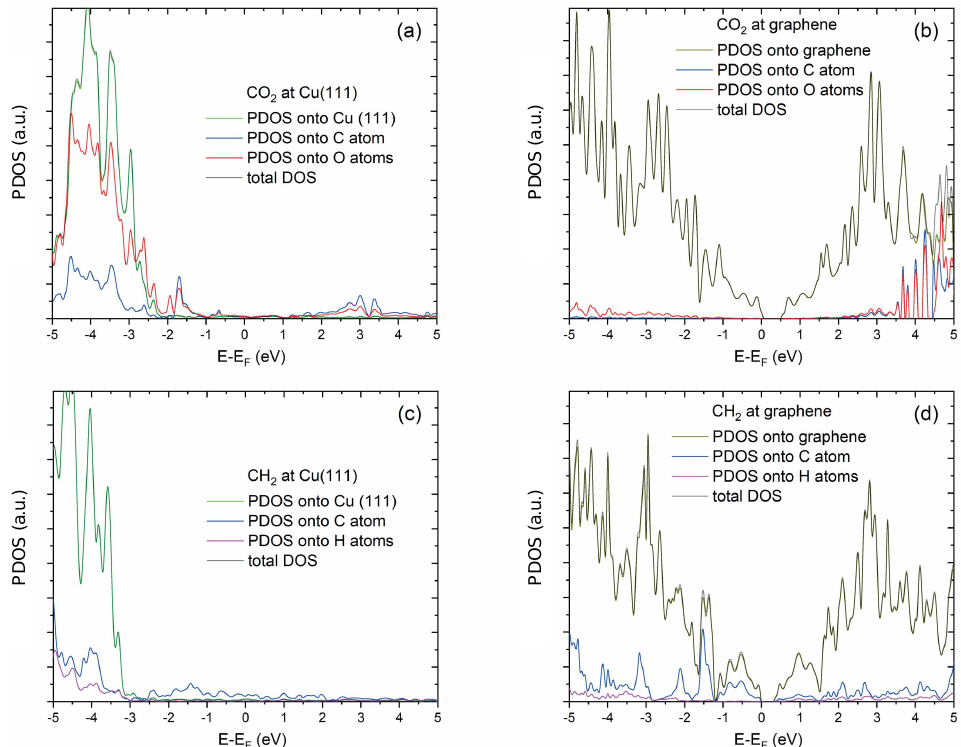
Figure 5. Projected density of states (PDOS) calculated for ( a ) CO 2 adsorbed at Cu (111) surface, ( b ) CO 2 adsorbed at graphene, ( c ) CH 2 adsorbed at Cu (111) surface, and ( d ) CH 2 adsorbed at graphene. PDOS onto all orbitals of H, C, and O atoms are magnified 10